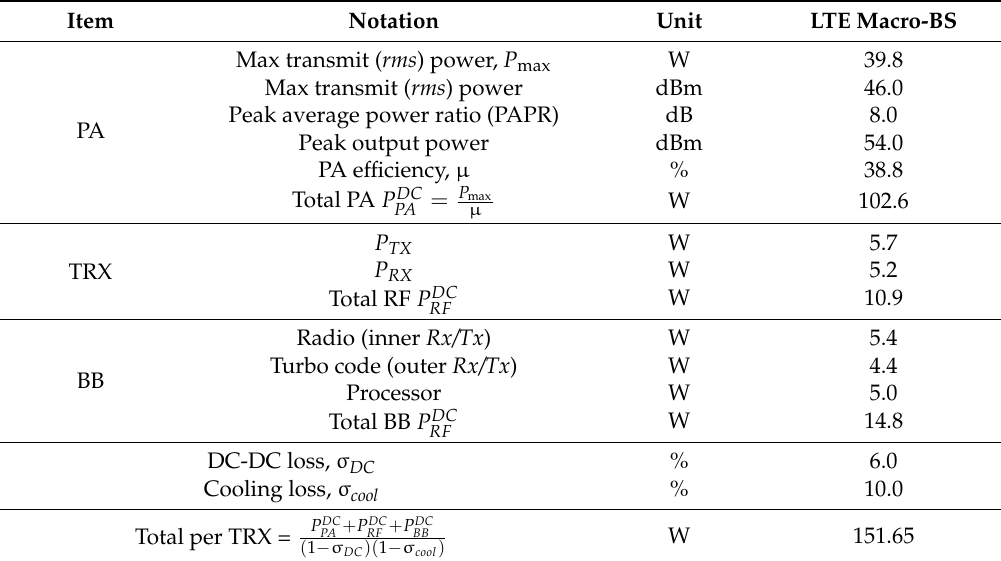
Table 1. Power consumption of the LTE-macro BS hardware elements